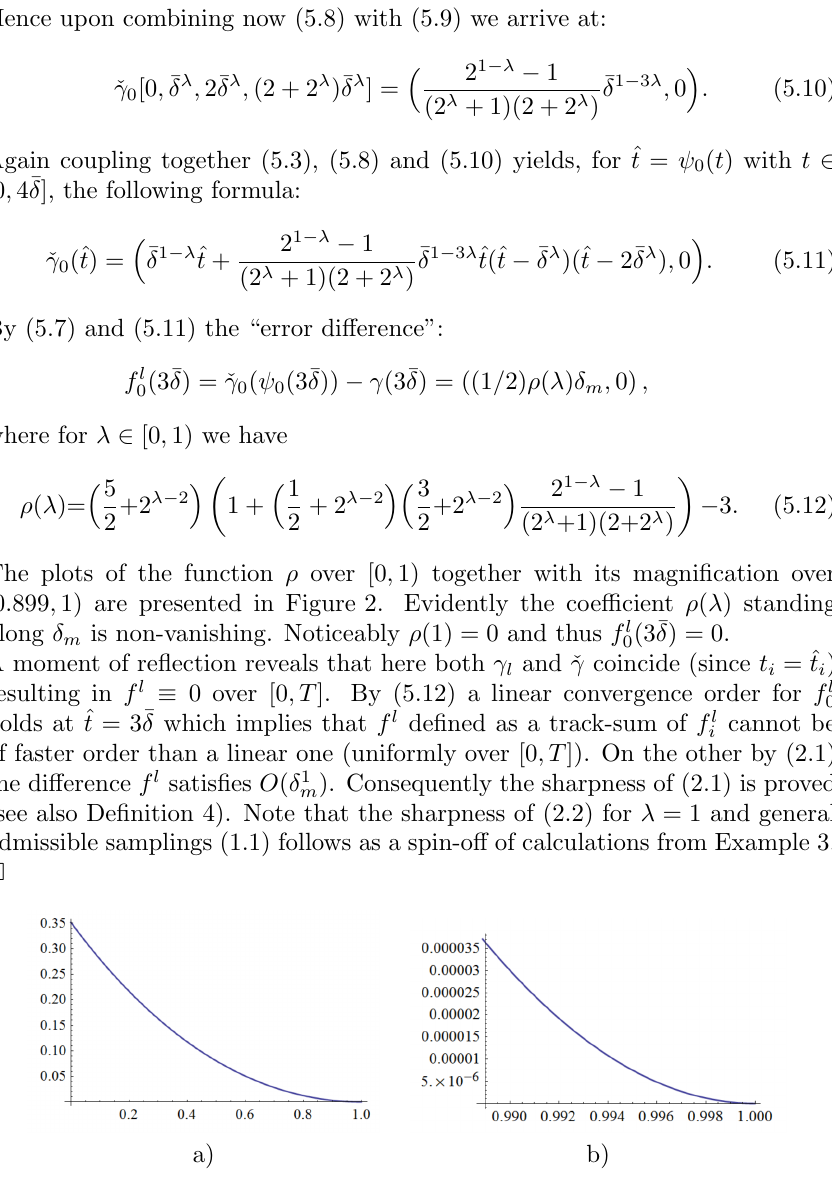
Figure 2. The plot of ρ ( λ ) > 0 from (5 . 12) over a) [0 , 1) and b) [0 , 899 ,